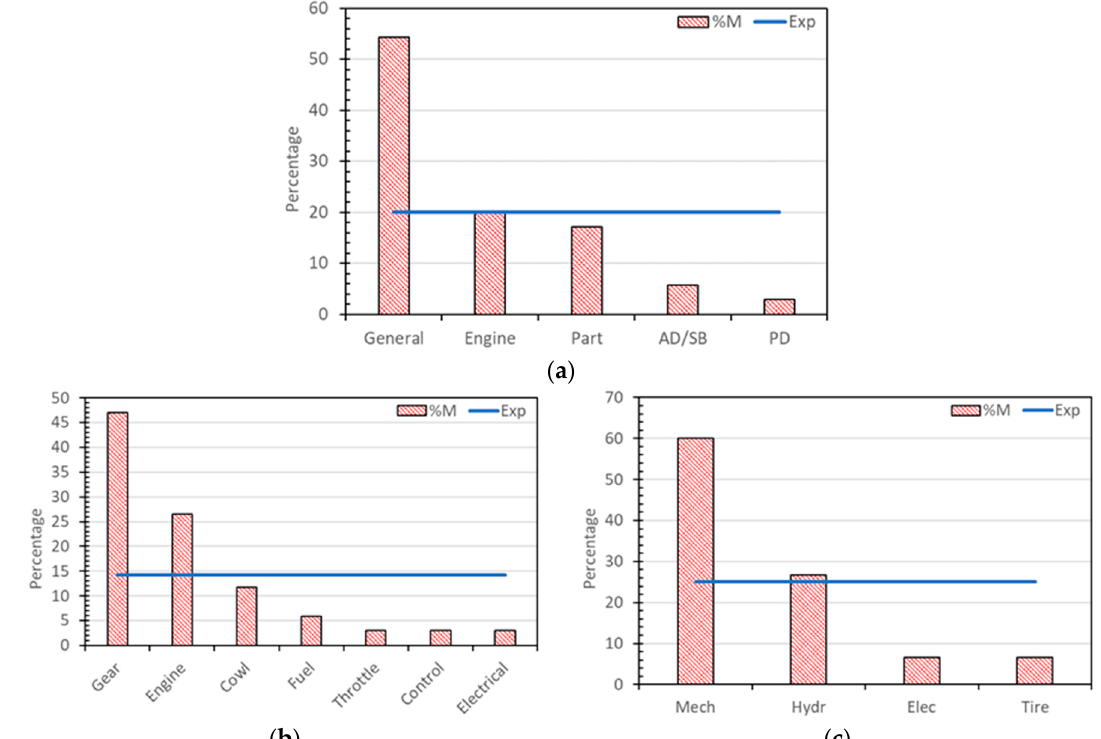
Figure 8. Results for the maintenance and technical issues for accidents with maintenance contributions: ( a ) the broad maintenance issue; ( b ) the system or component involved in the maintenance issue; ( c ) the type of gear fault.